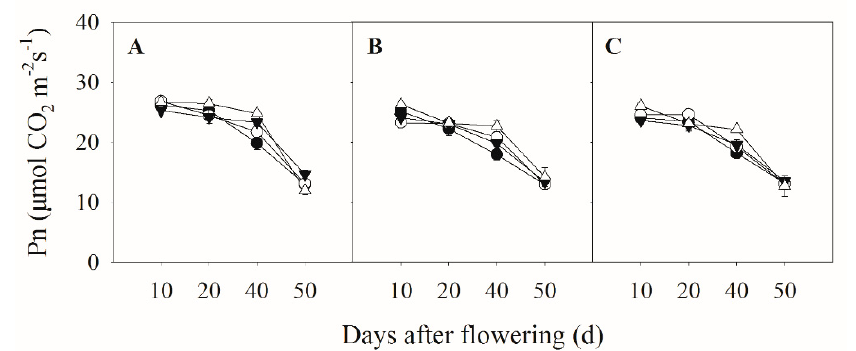
Figure 5. Dynamic changes of net photosynthesis rate (Pn) for the di ff erent soybean cultivars ( ● :